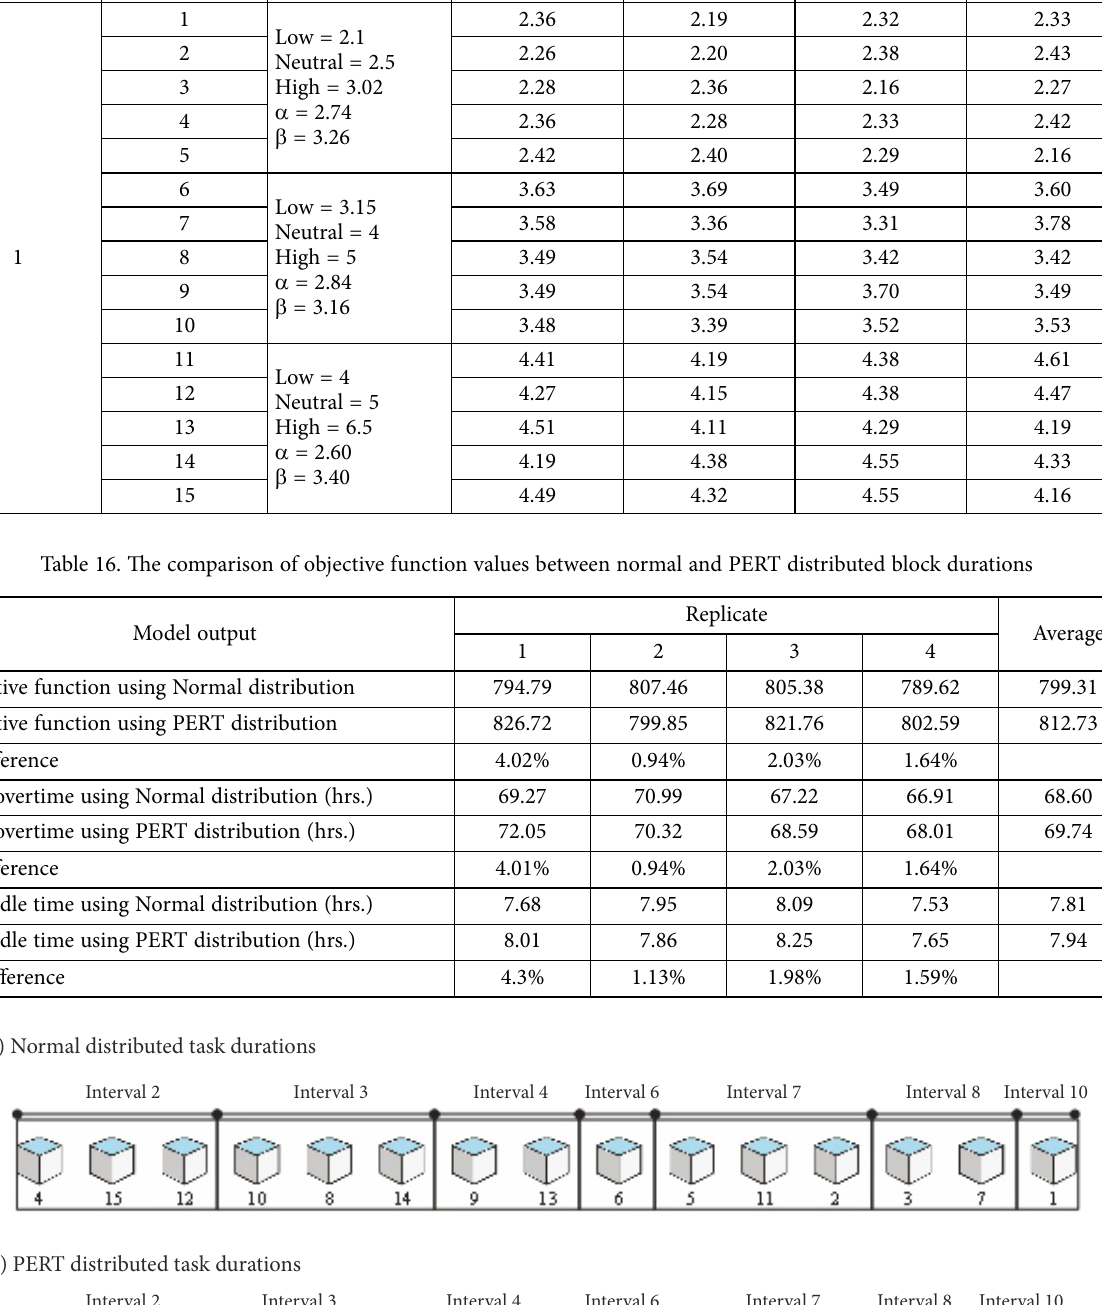
Table 15. The PERT generated four replicates of task durations for project 1 Project j